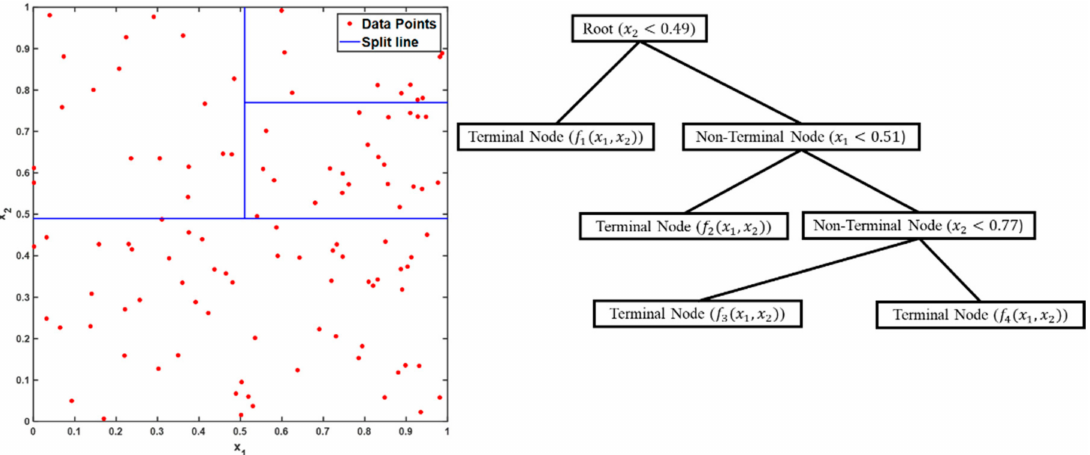
Figure 1. Representation of a binary decision tree in the independent variable space ( left ), and the corresponding structure of the model ( right ) for a synthetic